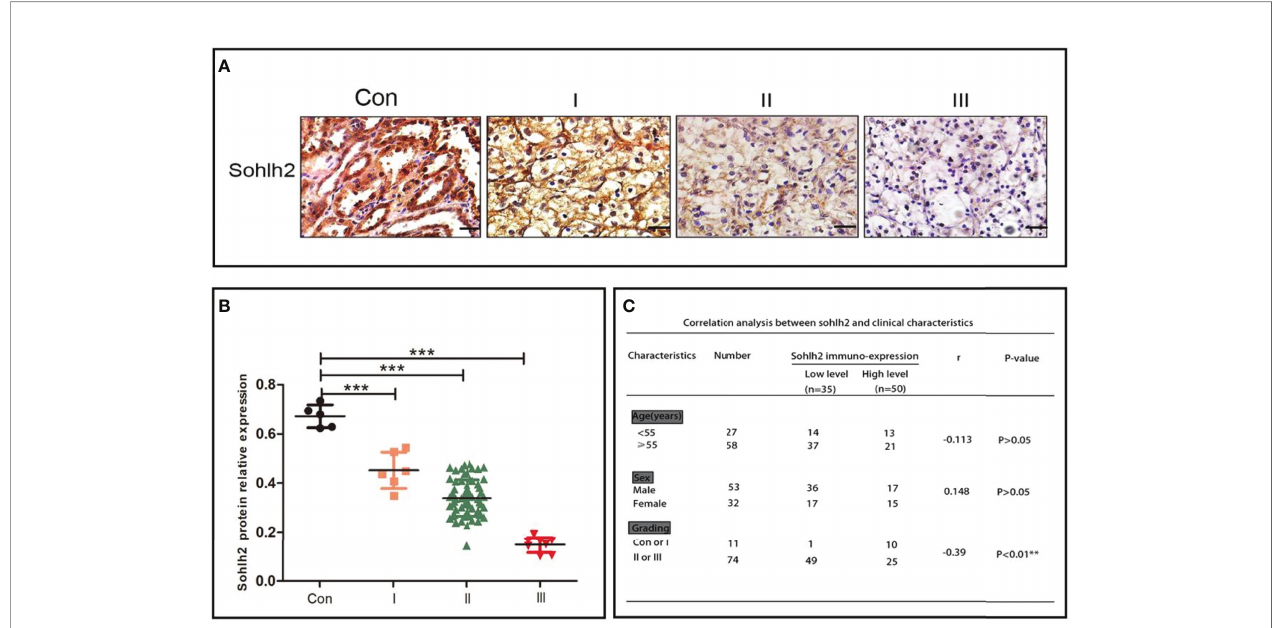
FIGURE 1 | Sohlh2 is downregulated in RCC. (A) The results of immunohistochemical staining of Sohlh2 in adjacent non-cancerous tissue and grade 1, grade 2, and grade 3 RCC tissues labeled as Con, I, II, and III, respectively. (B) The statistical analysis of immunohistochemical staining of Sohlh2. (C) The correlation between Sohlh2 and the clinical characteristics of RCC patients. RCC, renal cell carcinoma. It is statistically signi fi cant (***P < 0.0001).